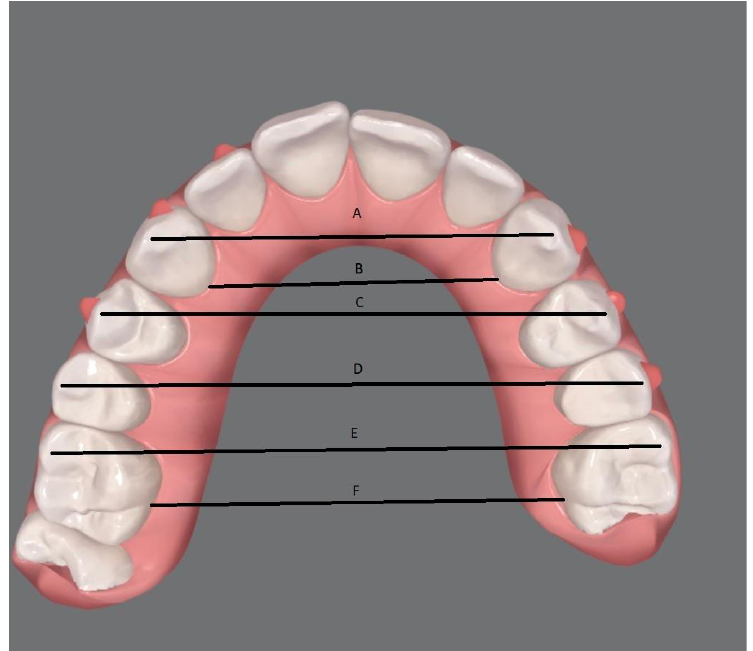
Figure 1. Transverse linear measurements performed on the maxillary arch for each model at T0, T1, and TC. ( A ) Intercanine cusp width; ( B ) intercanine gingival width; ( C ) first inter-premolar width; ( D ) second inter-premolar width; ( E ) first molar mesio-vestibular cusp width; ( F ) first molar gingival width.